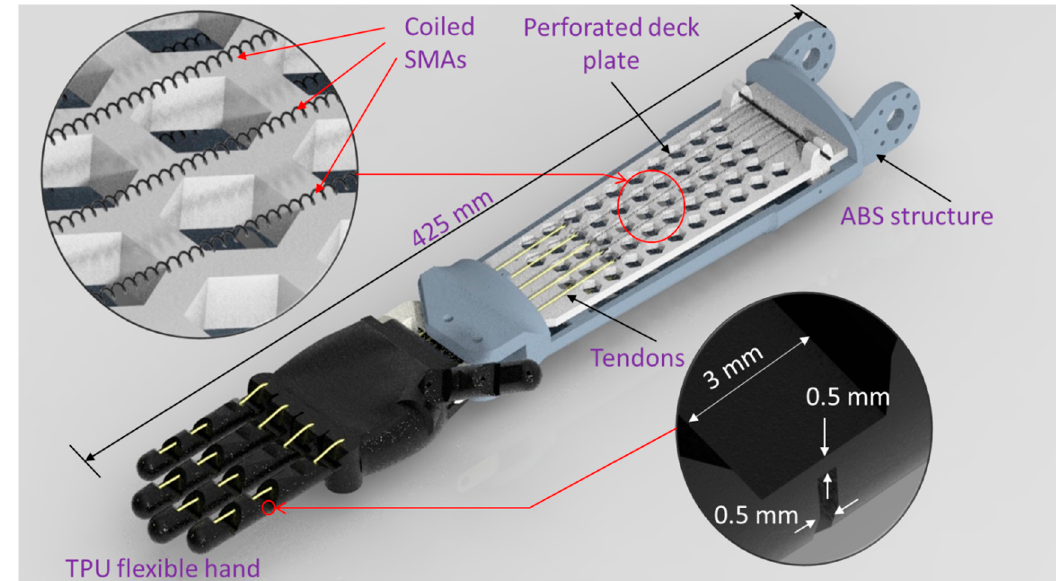
Figure 1. CAD (Computer Aided Design) model of the robotic hand actuated by helically wound shape memory alloy muscles with flexible thermoplastic polyurethane (TPU) fingers.